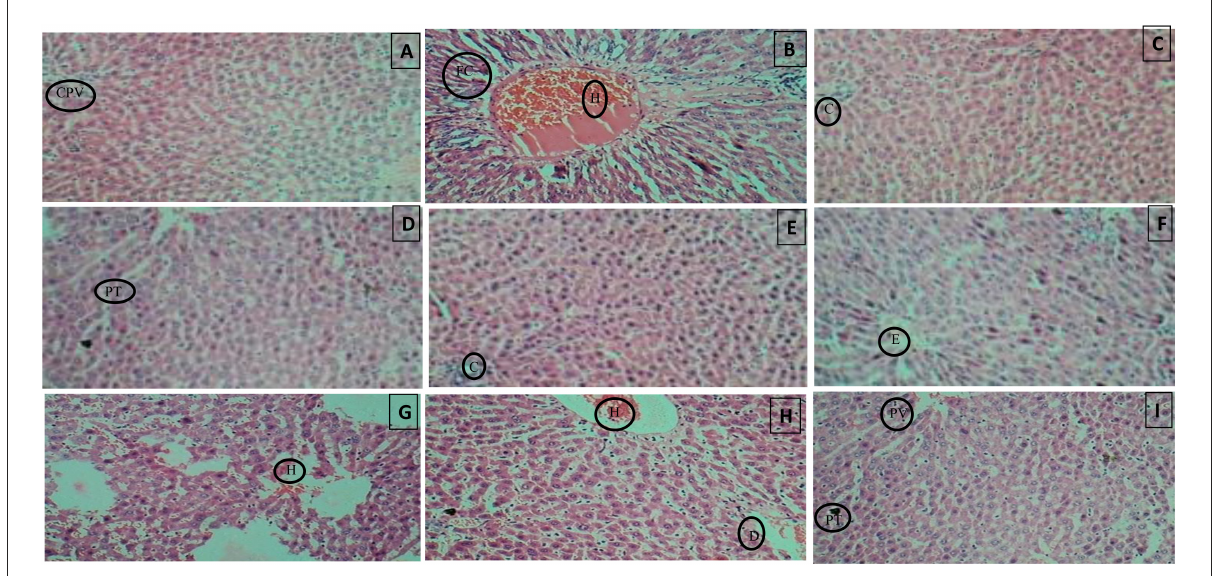
FIGURE11 (A) Normal control, (B) Diseased, (C) Pioglitazone 3.98 mg/kg, (D) Metformin 44.29 mg/kg, (E) Glimepiride 0.18 mg/kg, (F) Acarbose 8.86 mg/kg, (G) B. aurea 100 mg/kg, (H) B. aurea 200 mg/kg, and (I) B. aurea 400 mg/kg. Note: CPV, Central portal vein; FC, Fat cells; H, Hemorrhage; C, Congestion; PT, Portal tract; E, Edema; D, Dilation.